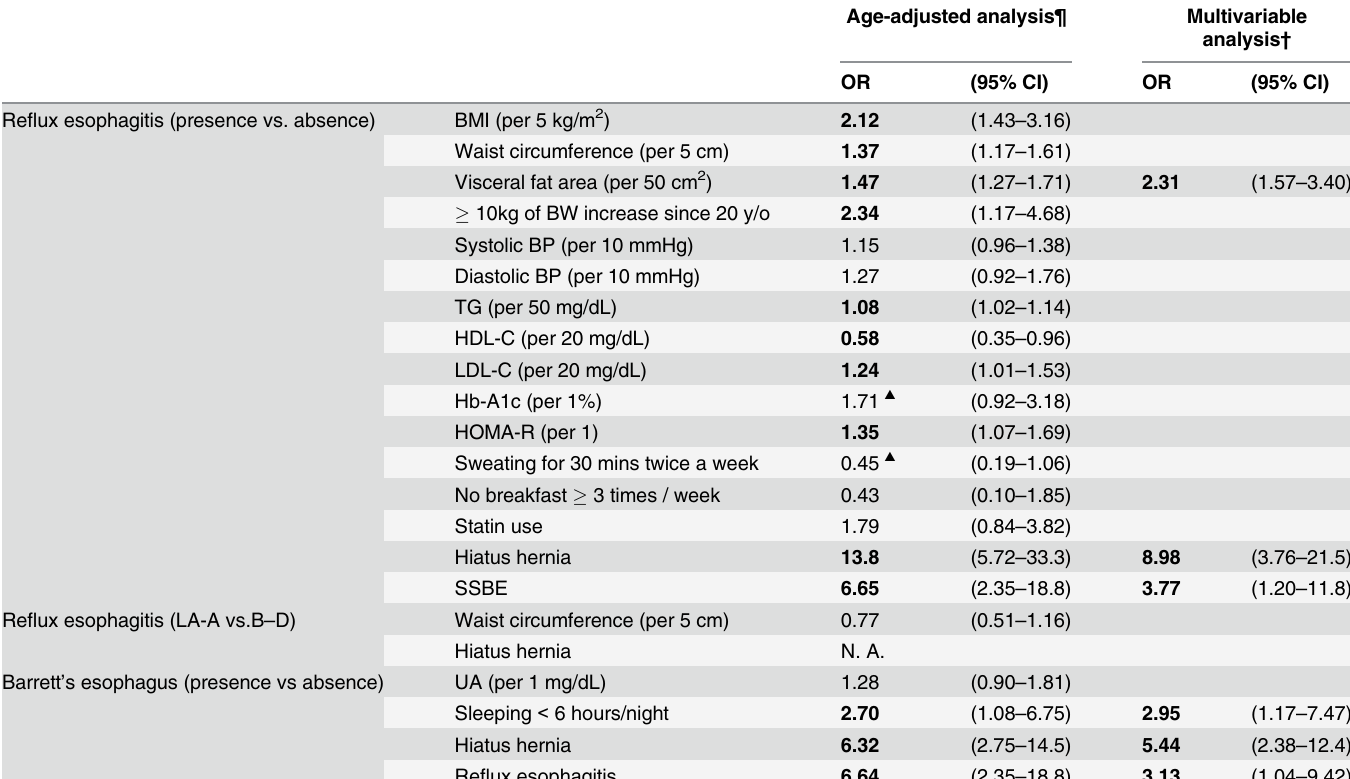
Table 5. Factors associated with reflux esophagitis or Barrett ’ s esophagus in